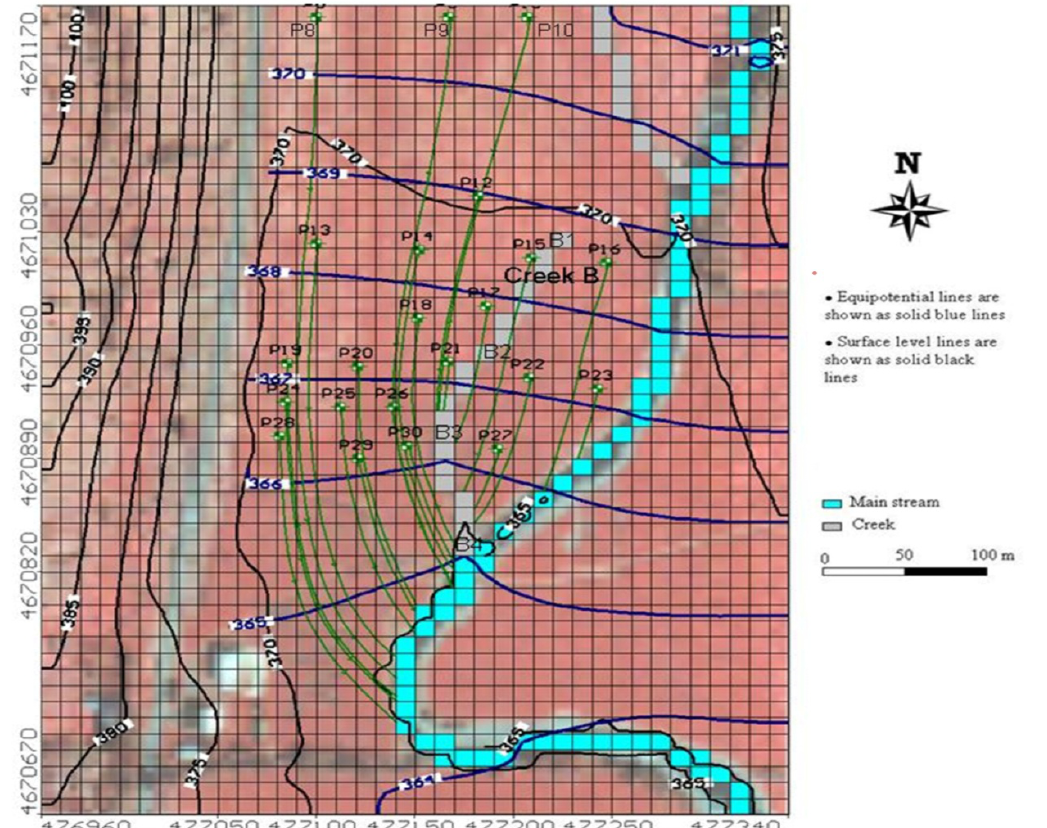
Figure 3. Map of groundwater table based on equipotential lines for the average state groundwater flow conditions over a period of 672 days showing the streamlines output for the 22 piezometers. The shadow area is a polygon mask applied to the 380 m by 500 m grid design and it is delineated by the corresponding eastern and western edge boundaries, a straight line in the northern edge, and an open ditch on the southern edge joining the main stream water